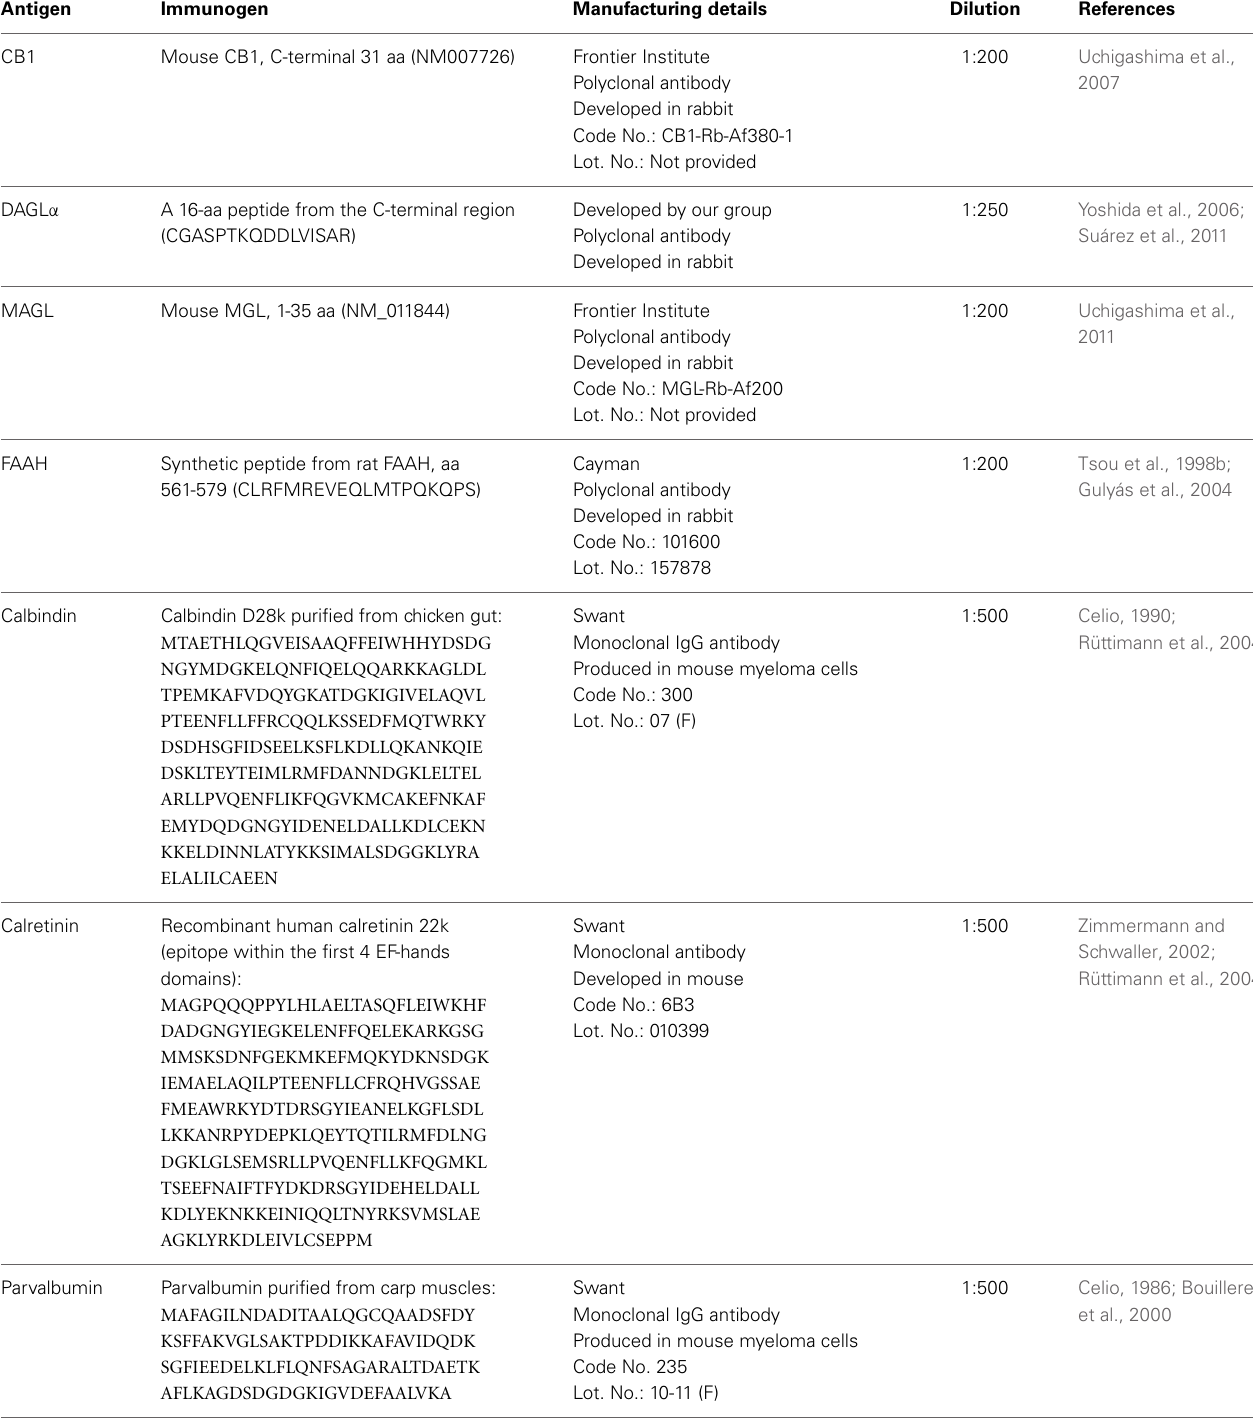
Table 1 | Primary antibodies